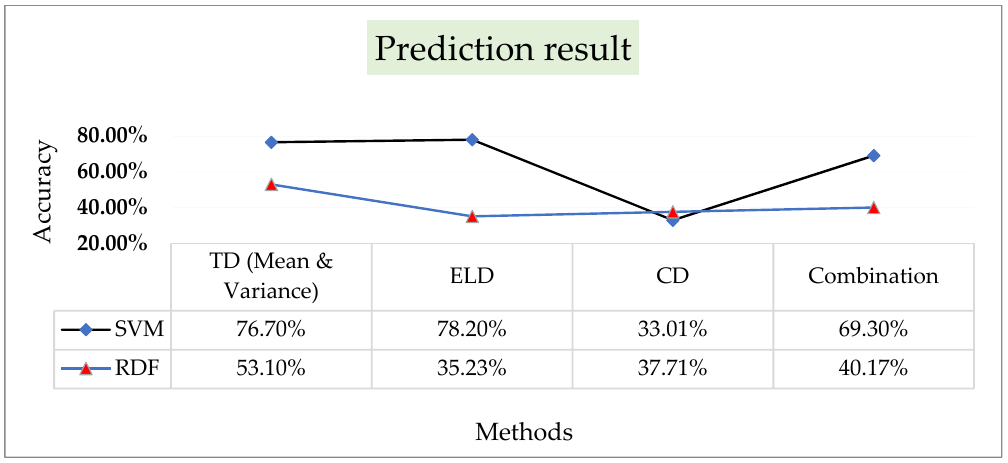
Figure 9. Prediction results of RDF and SVM algorithms by considering texture difference (TD) (Mean and Variance), elevation difference (ELD), coherence difference (CD) and Combination of three methods (4DR). Table 3. Producer accuracy, user accuracy and overall accuracy [34] for RDF and SVM classifiers by considering the combination method (3DR).